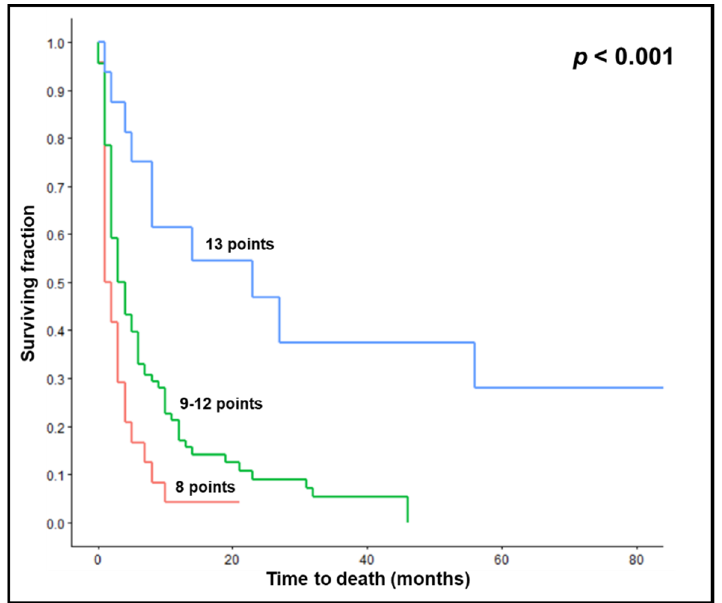
Figure 6. Model 2: Kaplan-Meier curves for survival of the three groups (8, 9–12, and 13 points).